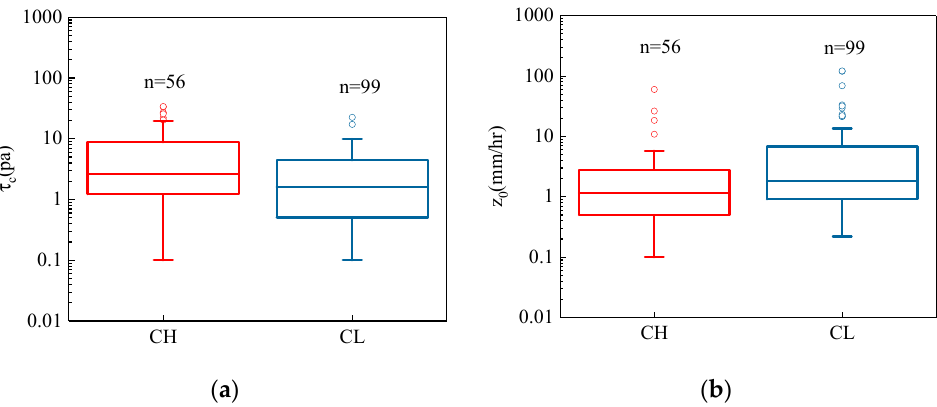
Figure 4. The range of derived parameters b 0 ( a ) and b 1 ( b ) for high-plasticity clay and low-plasticity clay.